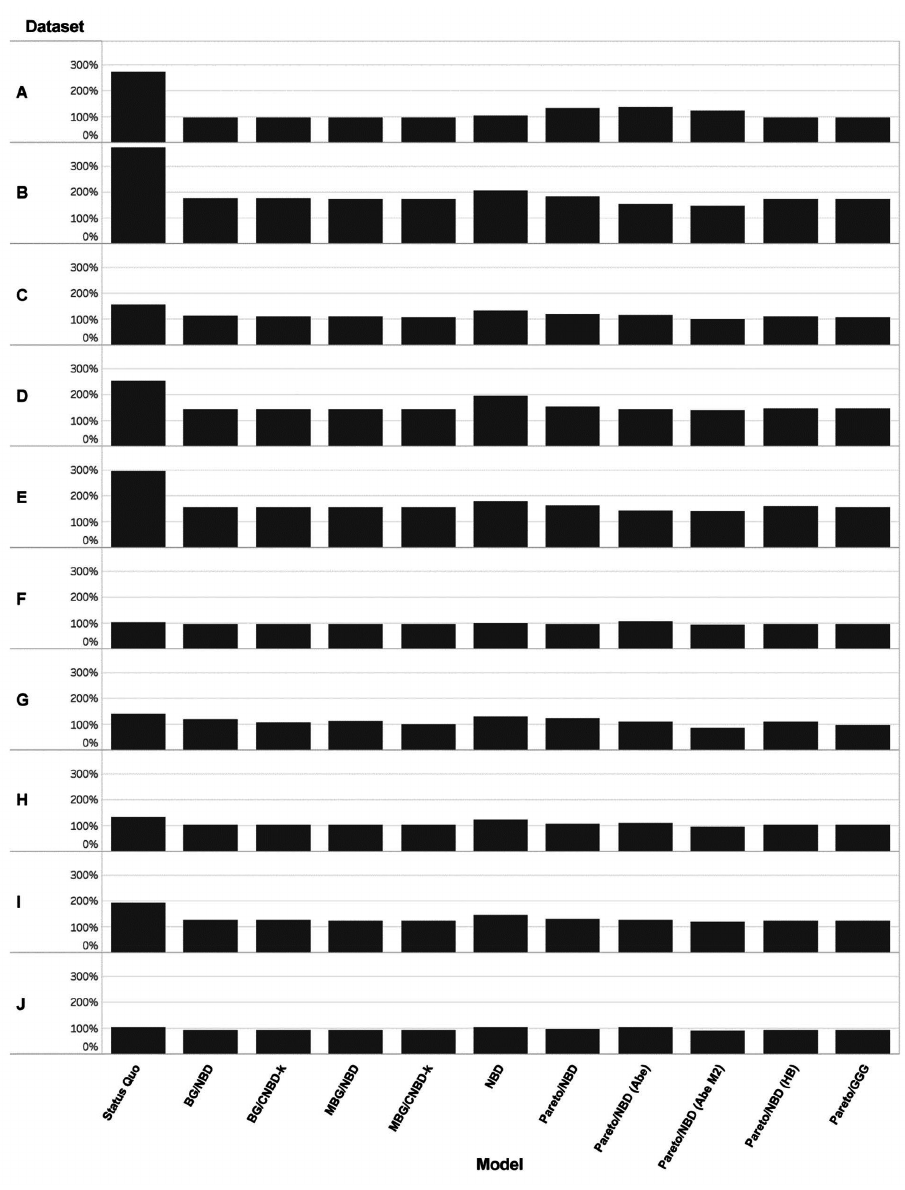
Figure 3. Results for MAE (customer-level, in %) for online stores